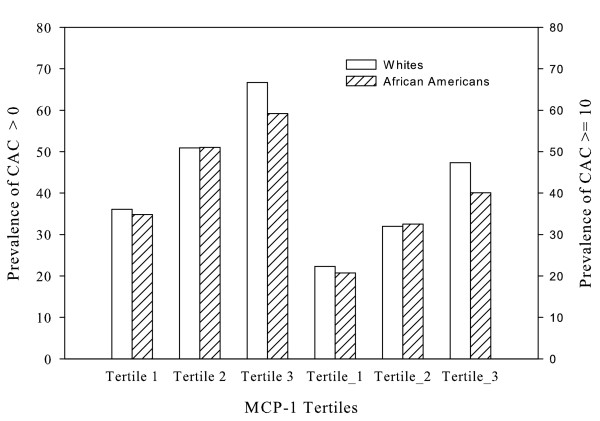
Prevalence of CAC (%) across MCP-1 tertiles by race. The three bar pairs on the left hand side are for CAC > 0 and those on the right hand side are for CAC ≥ 10. The tertile cutpoints for MCP-1 were based on the African-American sample and applied to the white sample.